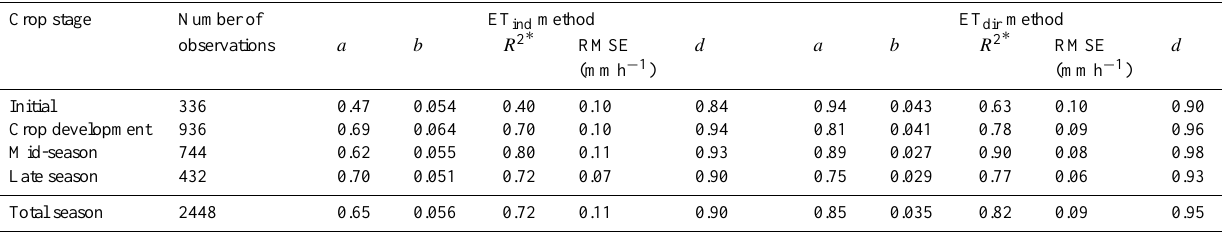
Table 3. Statistical summary of the correlation between observed and simulated hourly ET for each crop development stage, for both the ET dir method and the ET ind method.